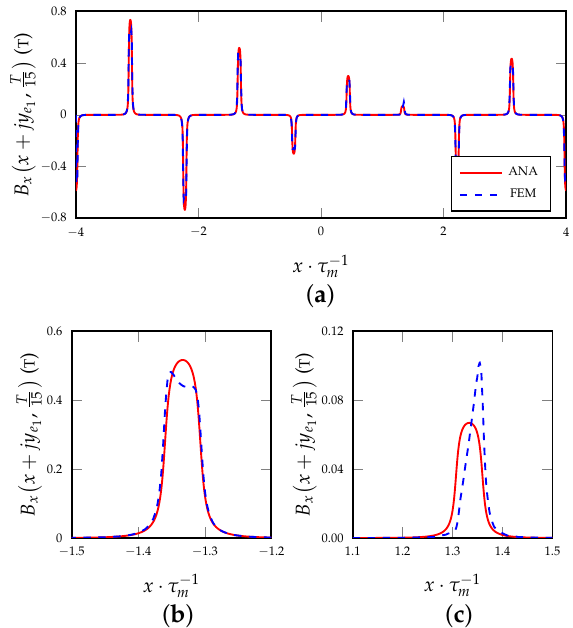
Figure 7. Analytical (6) and FEM (slotted machine of Figure 4a) armature reaction flux density tangential component on the exploration line y e 4 τ m N x = 10,000). ( b , c ) are two different selective zooms of ( a